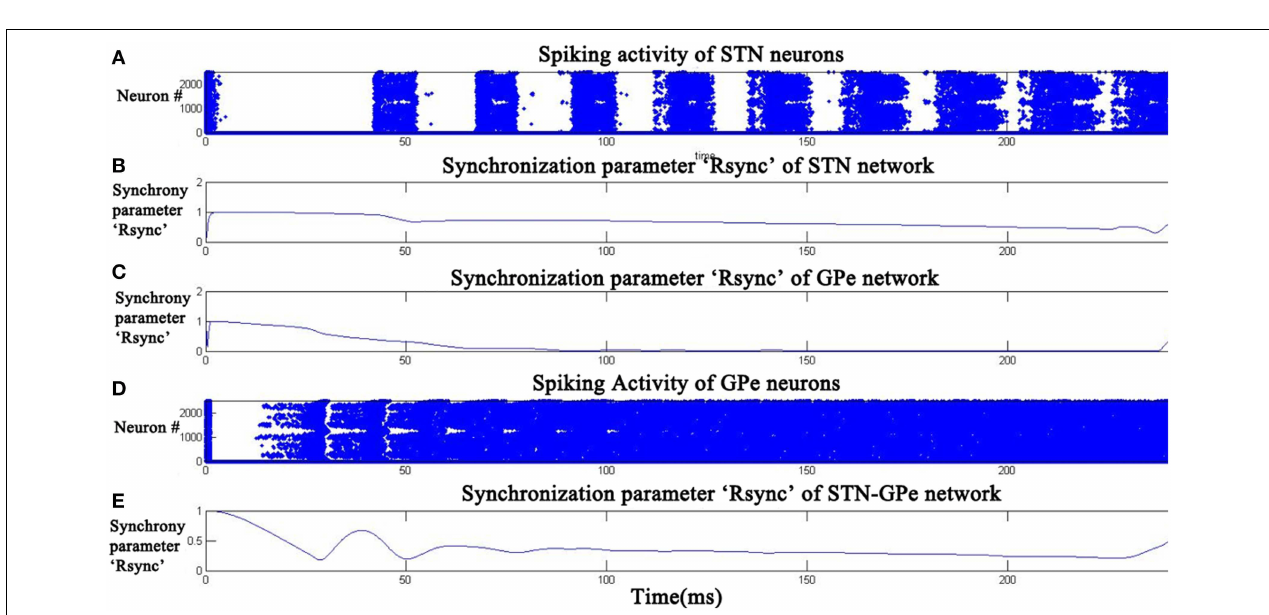
FIGURE 7 | Desynchronized activity of STN- GPe neurons at high dopamine level (DA = 0.9). Raster plots (A,D) indicate the activity of STN and GPe neurons with time. Plots (B,C,E) indicate the synchronization parameter (R sync ) calculated for STN, GPe, and STN-GPe respectively.